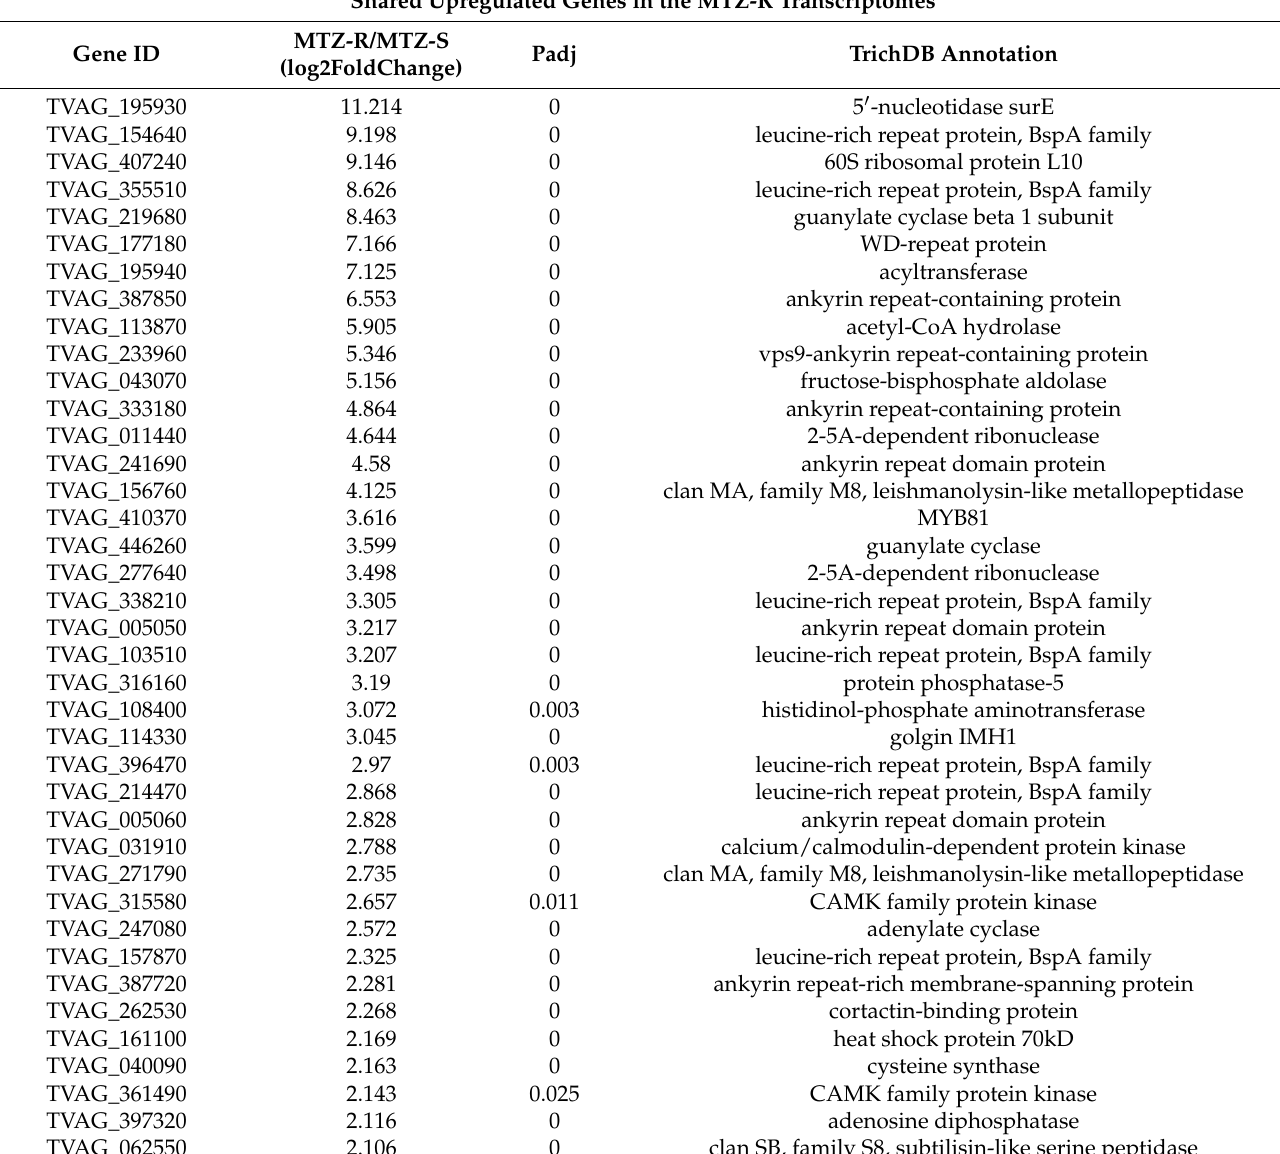
Table 1. Shared DEGs in all MTZ-R transcriptomes compared with those of MTZ-S. Shared Upregulated Genes in the MTZ-R